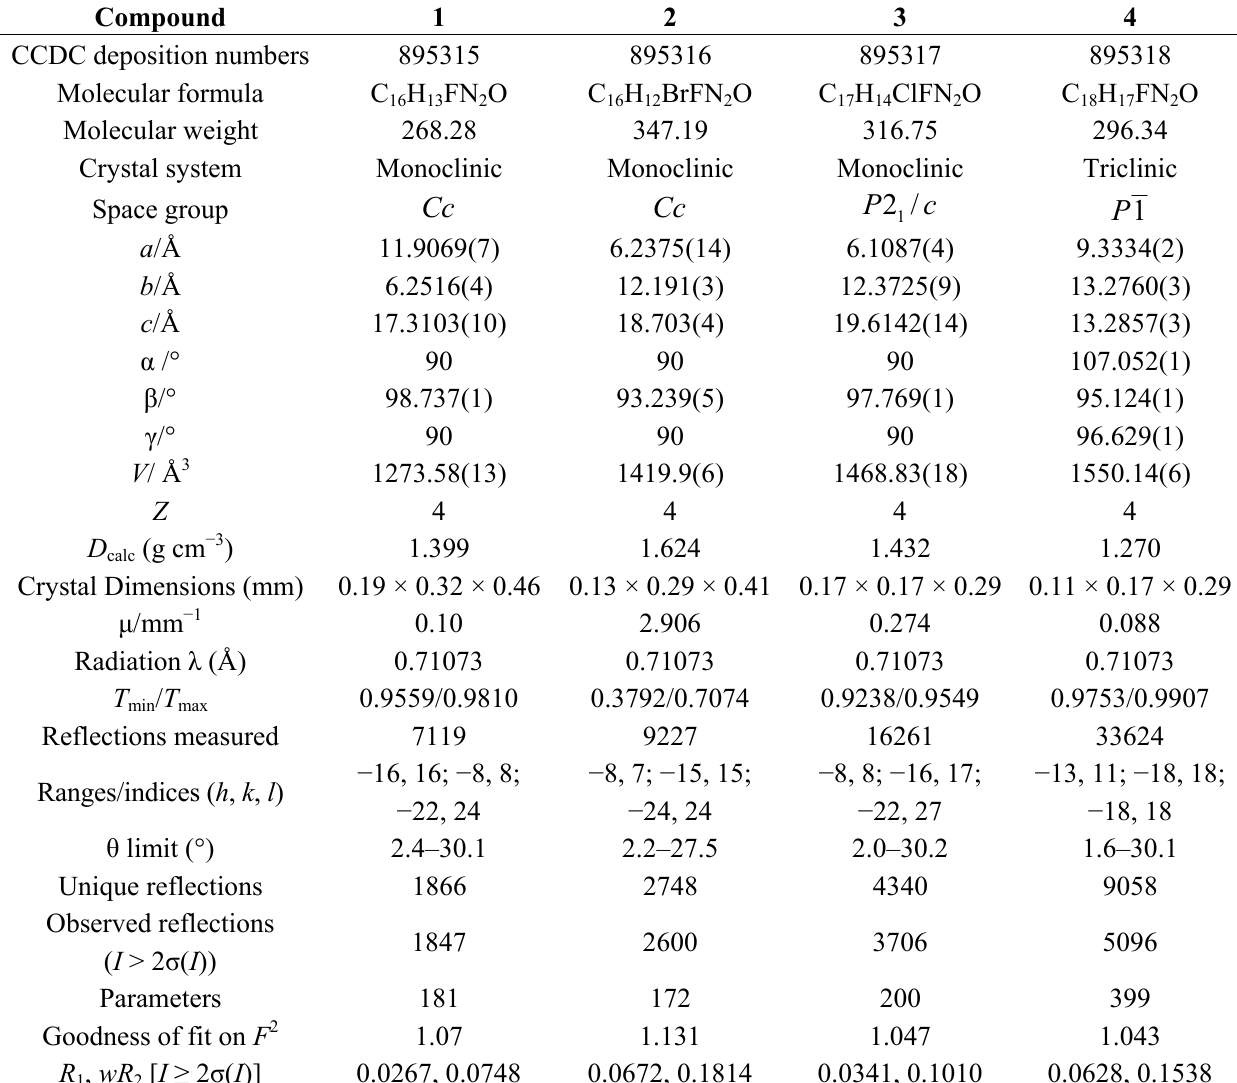
Table 1. Crystal data and parameters for structure refinement of 1 , 2 , 3 and 4